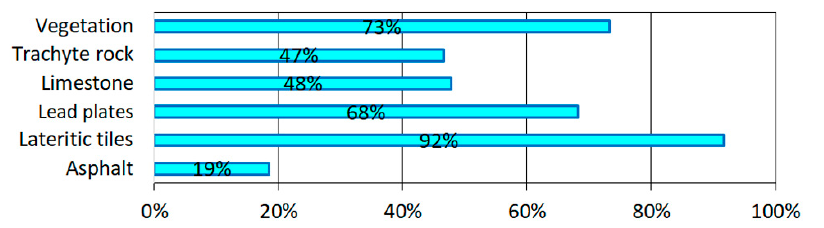
Figure 12. The percentage of MAE k-Totals values related to the spatial and spectral characteristics of and MIVIS image, the reference endmember set and LMM.